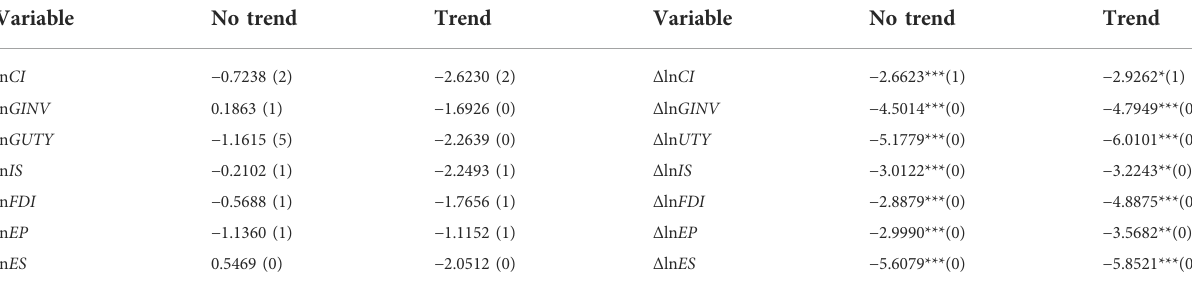
TABLE 1 Results of the serial unit root test of each variable based on the DF-GLS method.